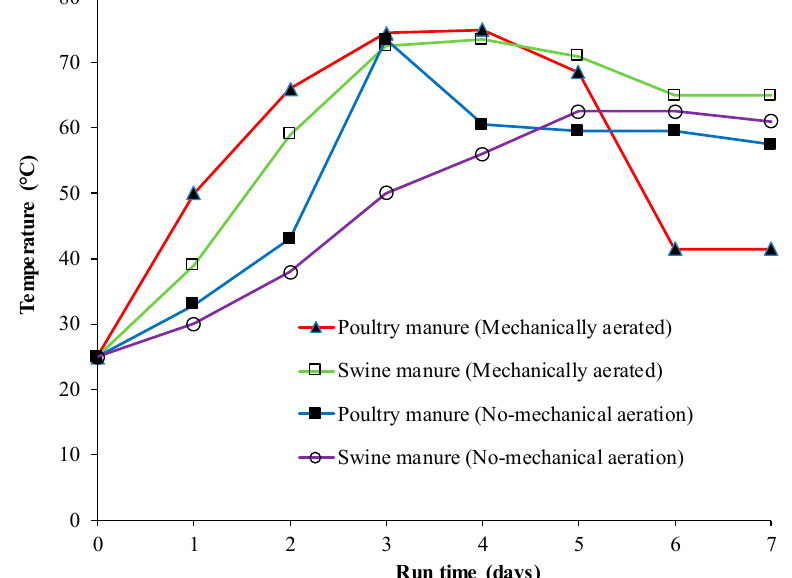
Figure 2. Temperature changes during composting of poultry and pig (swine) manure with or without mechanical aeration.